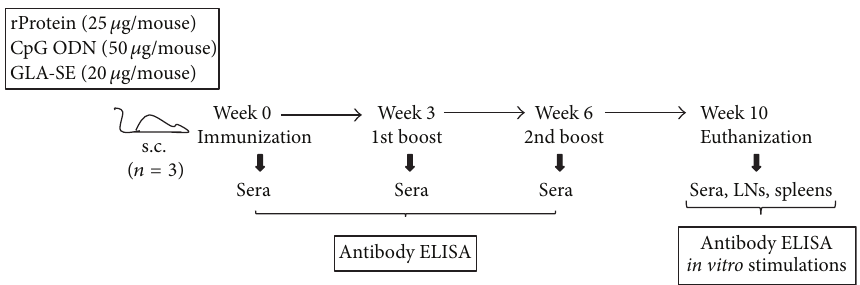
Figure 2: Schematic representation of the immunization protocol. Six- to 8-week-old female BALB/c mice were immunized s.c. in the hind foot pad with recombinant LdPxn1 or LdPxn2 protein (25 ug/mouse) with or without CpG ODN (50ug/mouse) or GLA-SE (20ug/mouse) adjuvants. Mice were boosted twice in 3 weeks interval. Sera were collected at each time of injection. Four weeks after the last boost mice were euthanized and sera, lymph nodes, and spleens were collected. Samples were used for antibody and cytokine analysis using standard